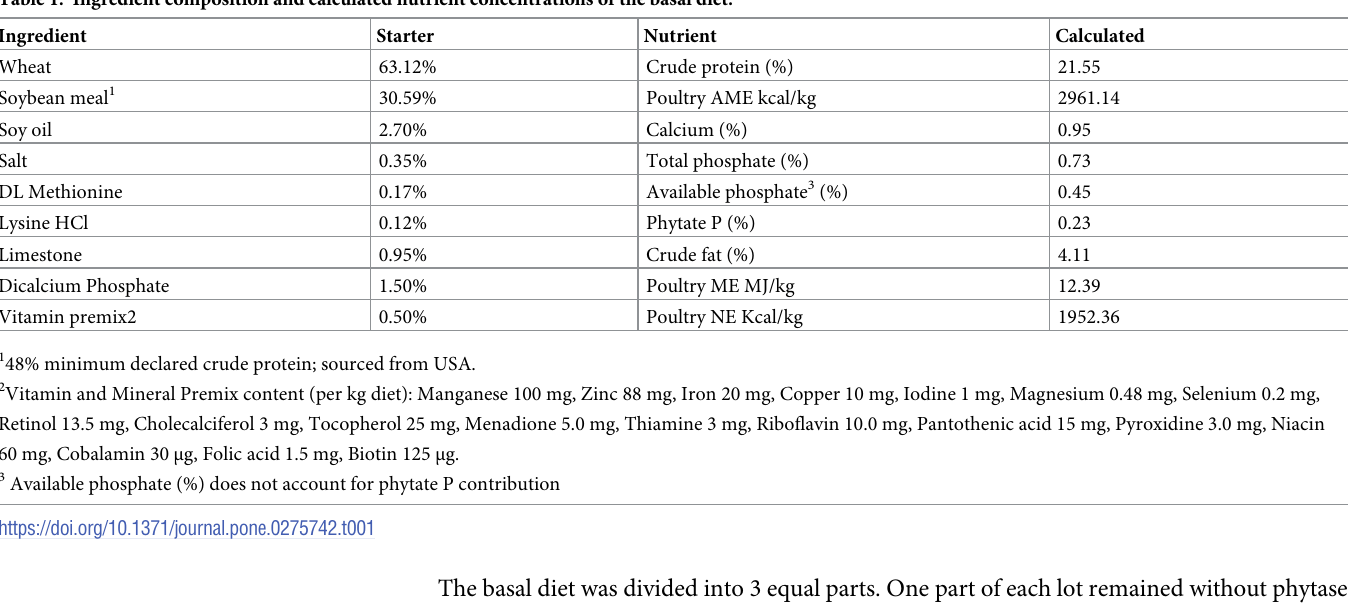
Table 1. Ingredient composition and calculated nutrient concentrations of the basal diet.